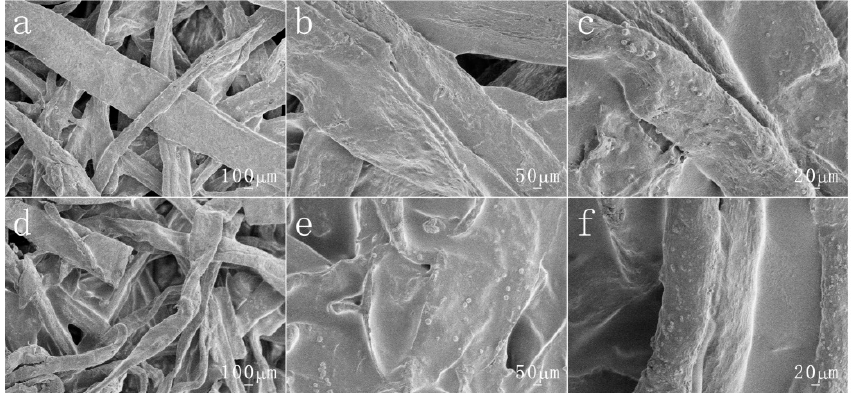
Figure 6. The different magnifications of SEM images by sodium hydroxide-treated (pH = 14) ( a – c ) pristine paper and ( d – f ) the copolymer-coated paper.